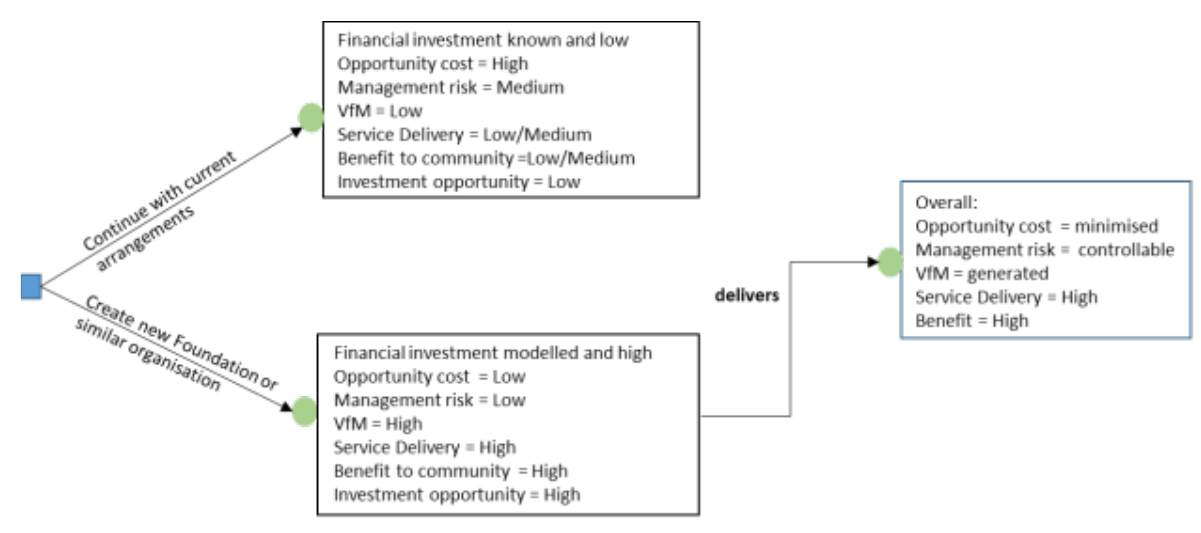
Figure 17: Headline comparator analysis of management